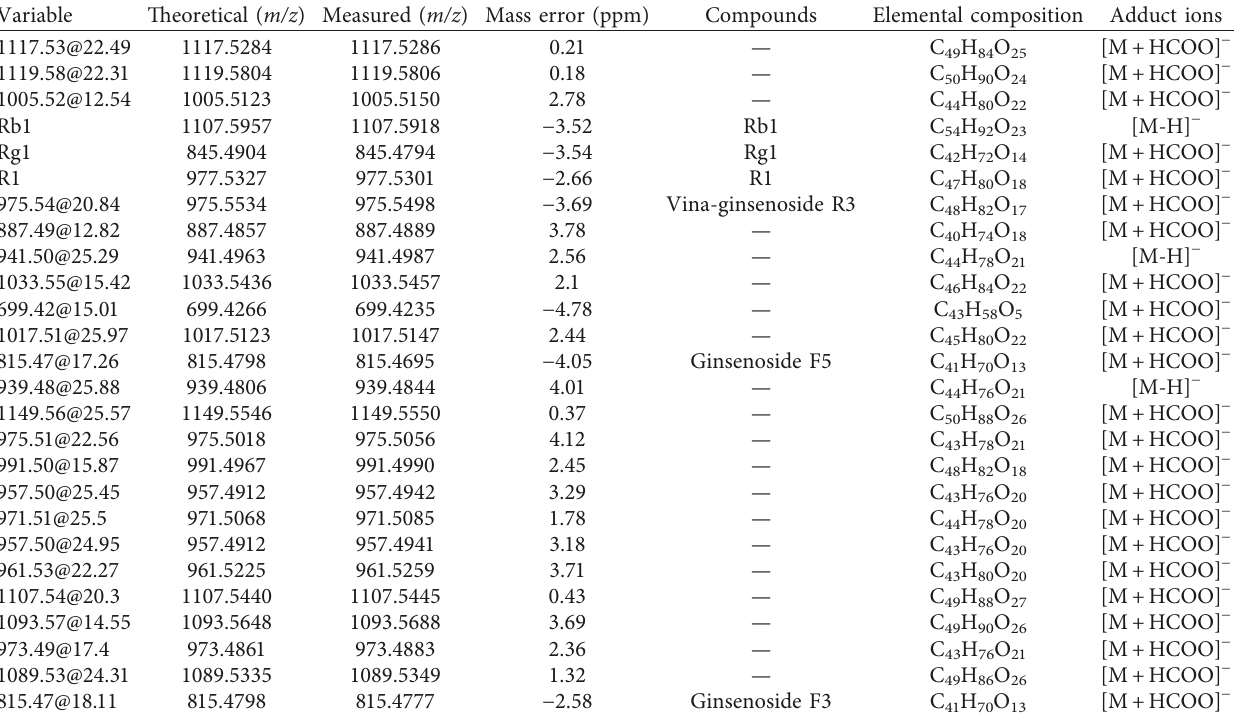
Table 9: Characterization of analysis markers in CGSL and FGSL based on − ESI full scan MS data. Variable Theoretical ( m/z ) Measured ( m/z ) Mass error